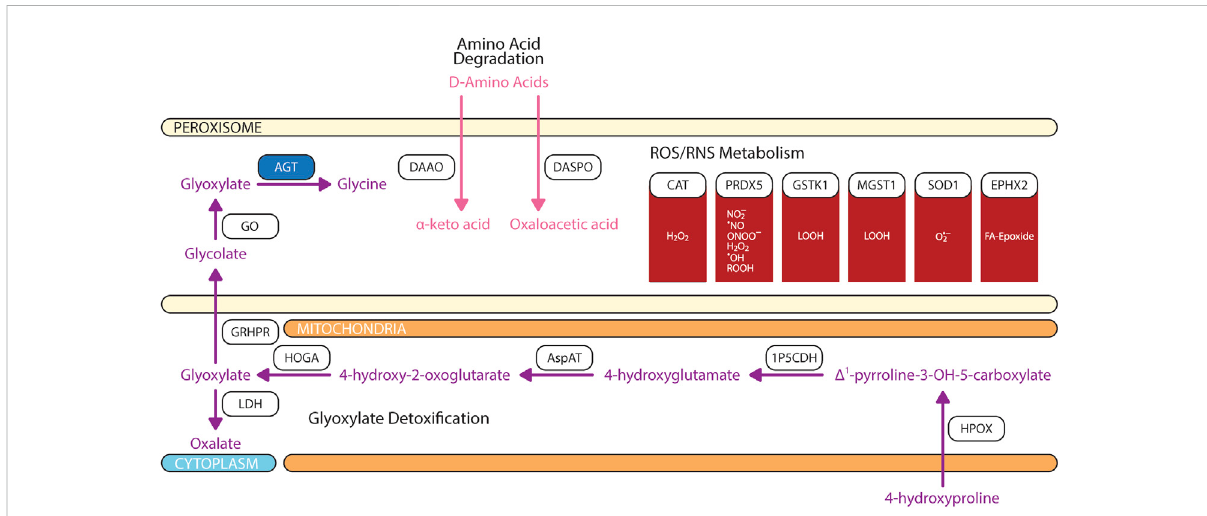
FIGURE 5 Biochemical pathways of glyoxylate, amino acids, and reactive oxygen/nitrogen species degradations. Blue box represents enzymes with published pathogenic variants resulting in ocular manifestations in humans. 1P5CDH, Δ 1 -pyrroline-5-carboxylate dehydrogenase; AGT, alanine: glyoxylate aminotransferase; AspAT, aspartate aminotransferase; CAT, catalase; DAAO, D-amino acid oxidase; DASPO, D-aspartate oxidase; EPHX2, epoxide hydrolase 2; GO, glycolate oxidase; GRHPR, glyoxylate and hydroxypyruvate reductase; GSH, glutathione; GSTK, glutathione transferase kappa; HOGA, 4-hydroxy-2-oxoglutarate aldolase; HPOX, hydroxyproline oxidase; LDH, lactate dehydrogenase; MGST, microsomal glutathione S-transferase; PRDX5, peroxiredoxin 5; SOD1, superoxide dismutase. The fi gure was partly generated using Servier Medical